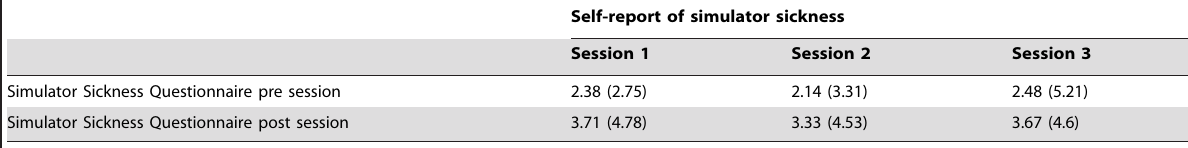
Table 4. Unwanted side effects during each session of the ImPACT